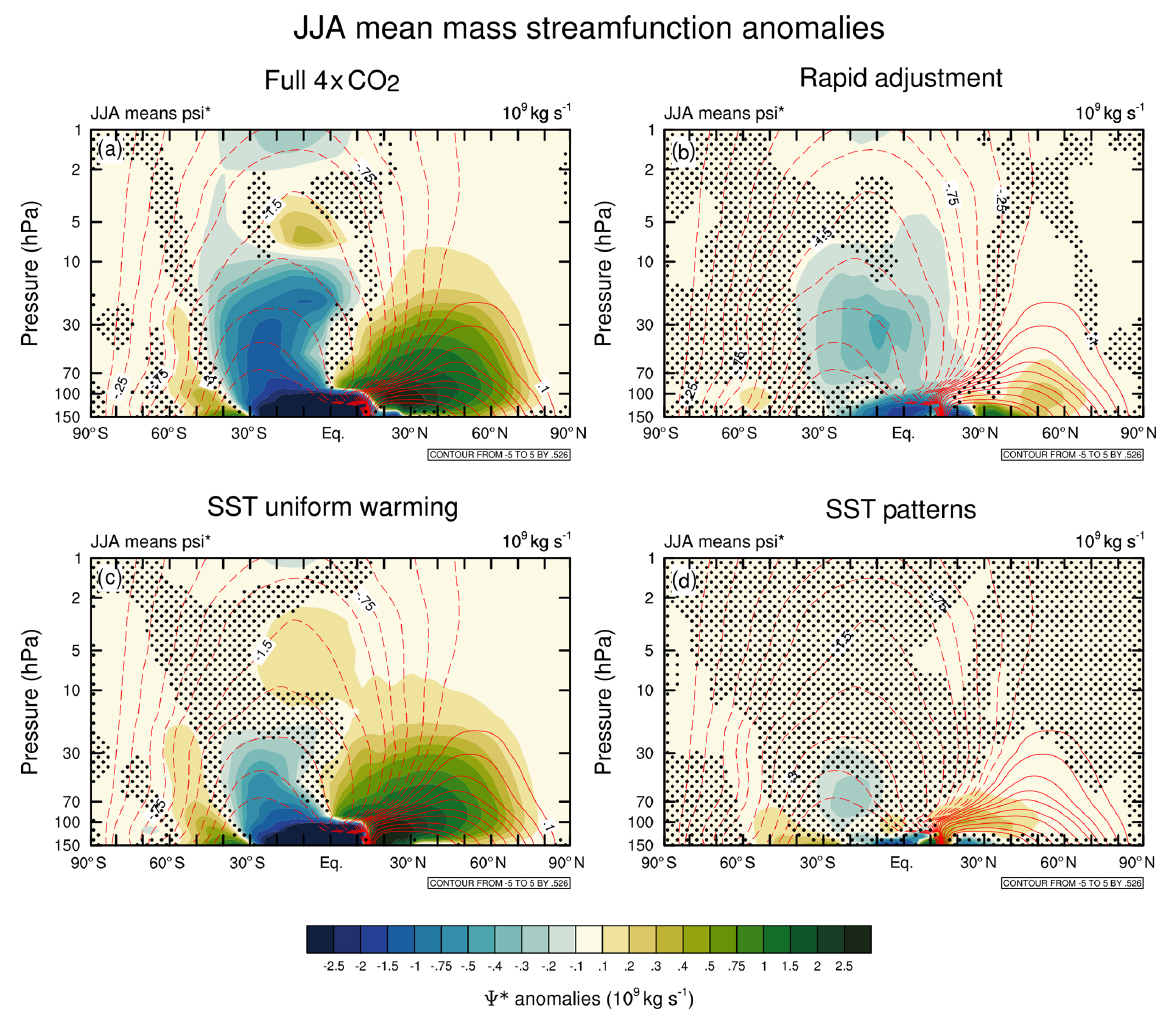
Figure 6. As in Fig. 5, but for the JJA